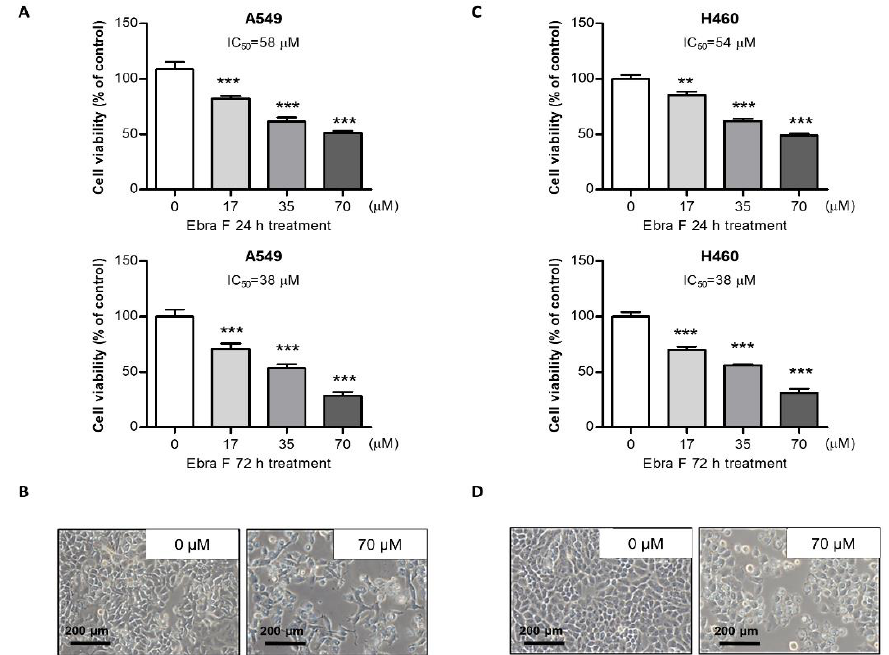
Figure 1. Effect of ebractenoid F on lung cancer cell growth. The morphology of lung cancer cells treated with ebractenoid F. Morphological changes of A549 and H460 lung cancer cells were observed under a phase-contrast microscope ( A , C ). Concentration-dependent effect of ebractenoid F on A549 and H460 cells observed using the cell viability assay (MTT assay) after 24 h and 72 h ( B , D ). The data were expressed as the mean ± S.D. of three experiments. **, p < 0.01; ***, p < 0.001; n.s. (not statistically significant) indicates statistically significant differences from the control group.